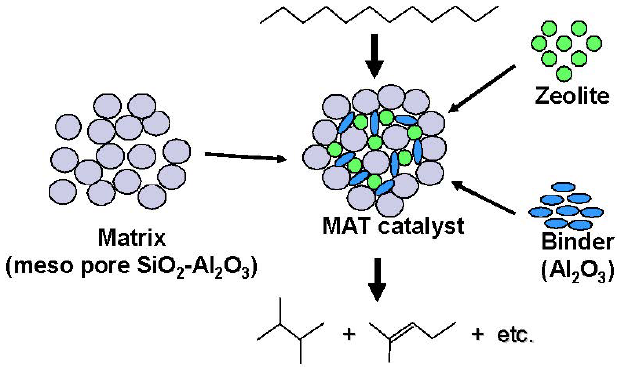
Figure 12. Structure and reactivity of a mixed catalyst (MAT catalyst) using a matrix amorphous silica-alumina, zeolite and binder